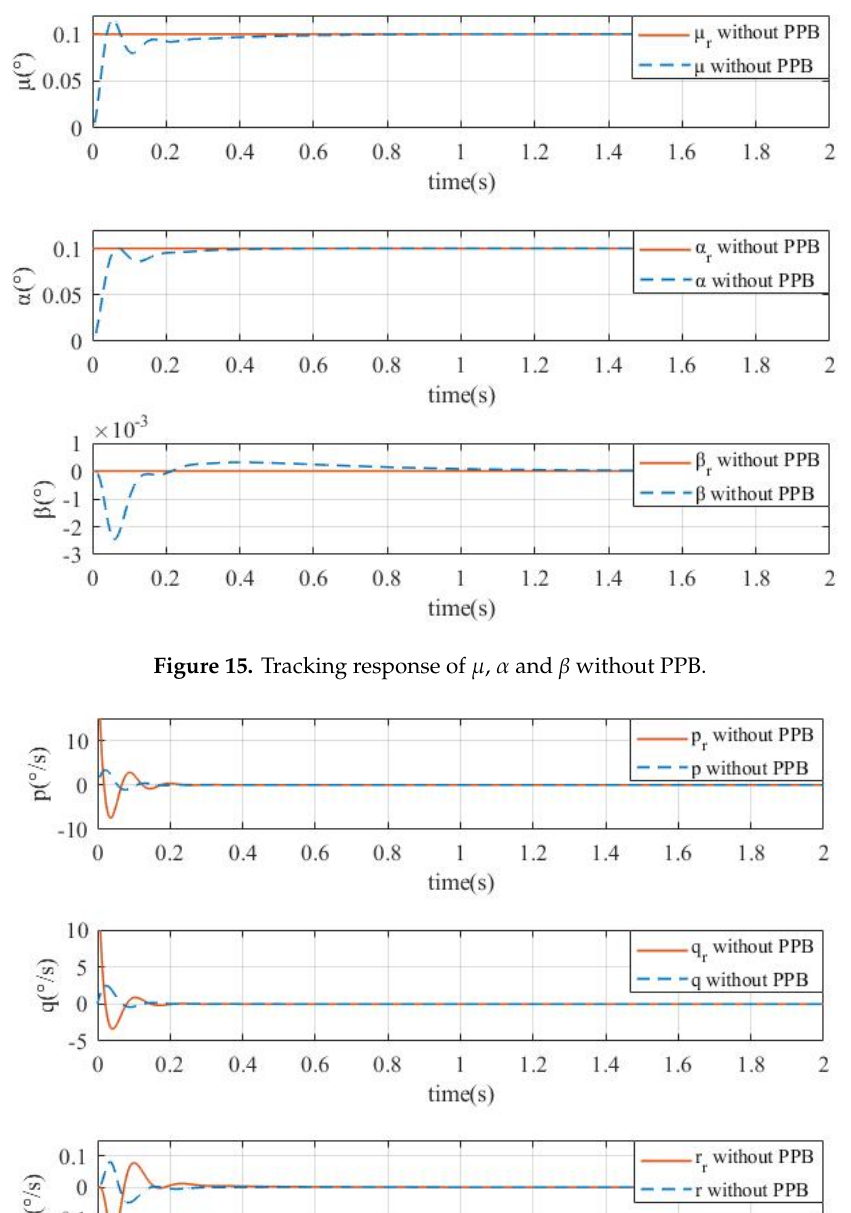
Figure 14. Angular rate tracking with actuator faults.